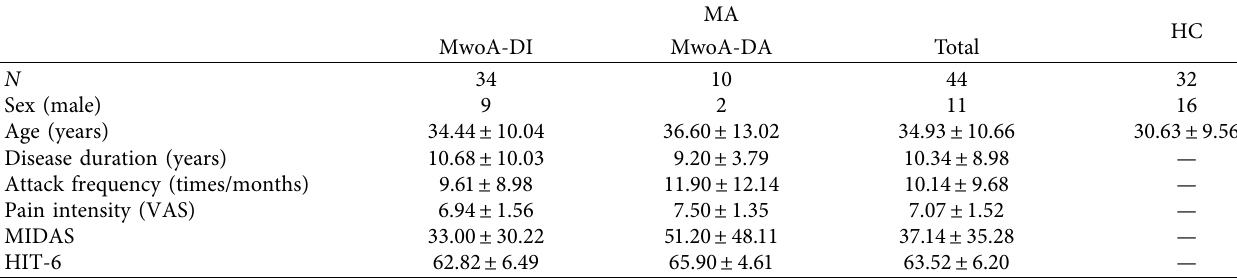
Table 1: Clinical data of MwoA patients and